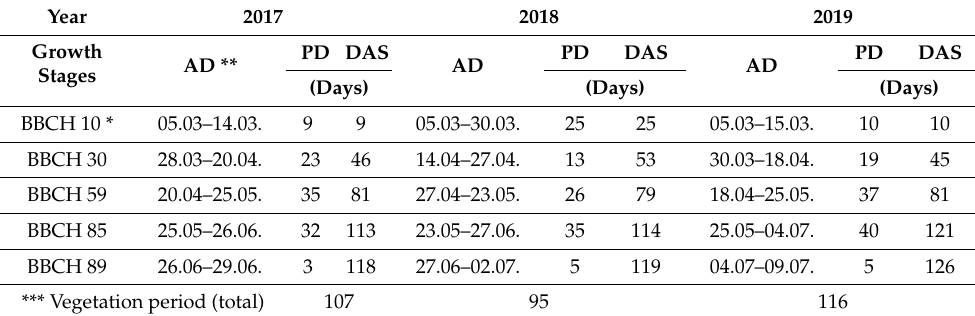
Table 2. Black oat growing stages (BBCH) and its dates of occurrence during the